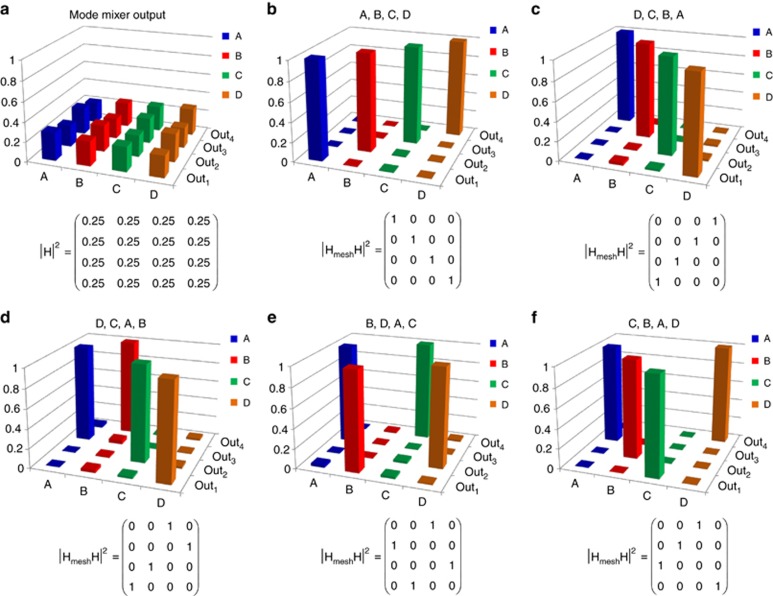
On-chip mode sorting. The mesh transmission matrix Hmesh can be configured in order to sort the reconstructed modes {A,B,C,D} arbitrarily at the output ports {Out1, Out2, Out3, Out4} of the mesh according to any 4 × 4 permutation power transmission matrix |HmeshH|2. Given the mode scrambling introduced by the mode mixer H, spreading the power of the input modes almost equally in the input waveguides of the mesh (a), panels (b–f) show the normalized light power at the output ports of the mesh, when it is configured to extract the modes in the follow order: (b) A, B, C, D; (c) D, C, B, A; (d) D, C, B, A; (e) C, A, D, B; (f) C, B, A, D.